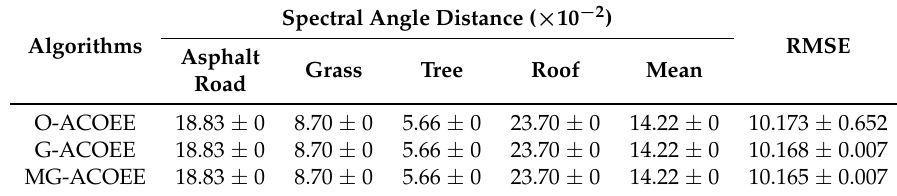
Table 5. Comparison of O-ACOEE, G-ACOEE, and MG-ACOEE (full constraint) on endmember extraction accuracy for Urban data.